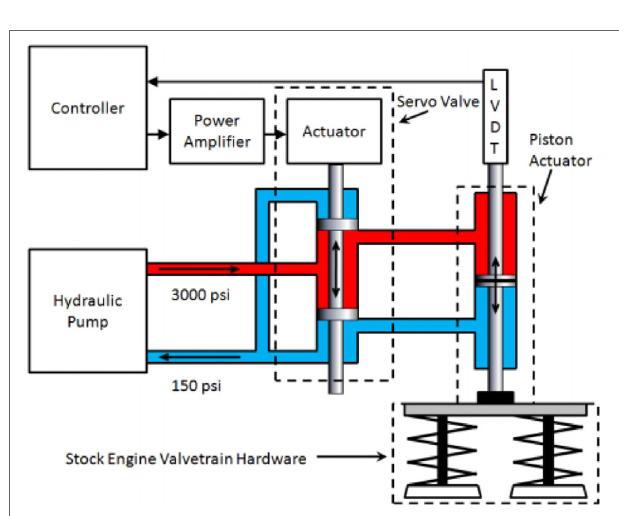
FigUre 2 | Schematic of the variable valve actuation